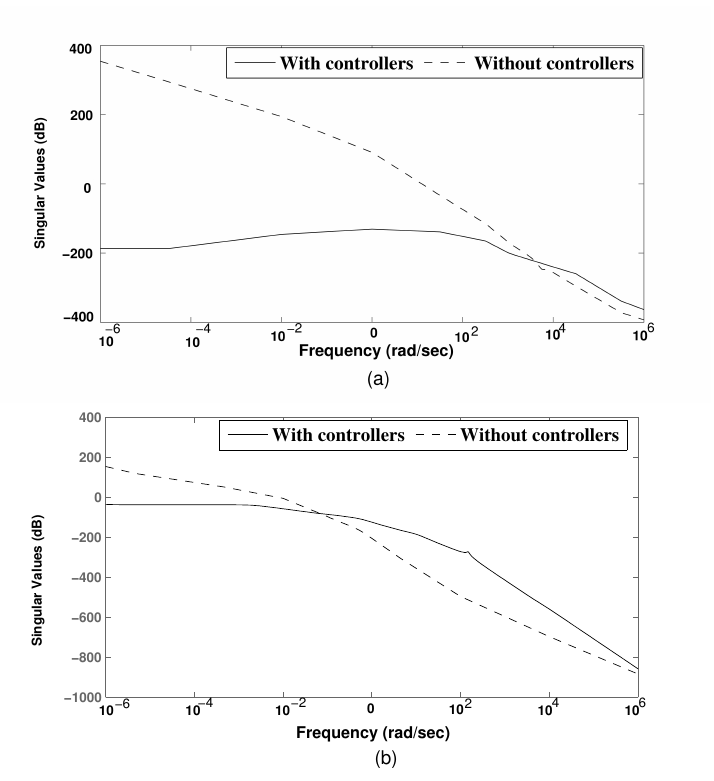
Figure 8. ( a ) Singular value plot of frequency control loop. ( b ) Singular value plot of the pitch angle control loop.